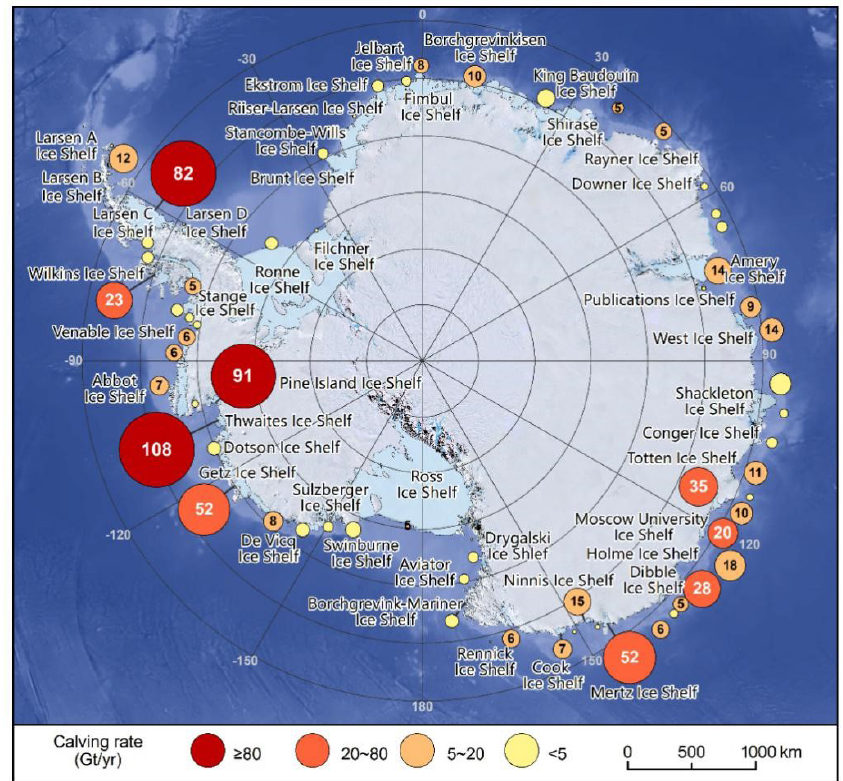
Figure 8. Spatial distribution of average calving rate (Gtyr − 1 ) of Antarctic ice shelves from August 2005 to August